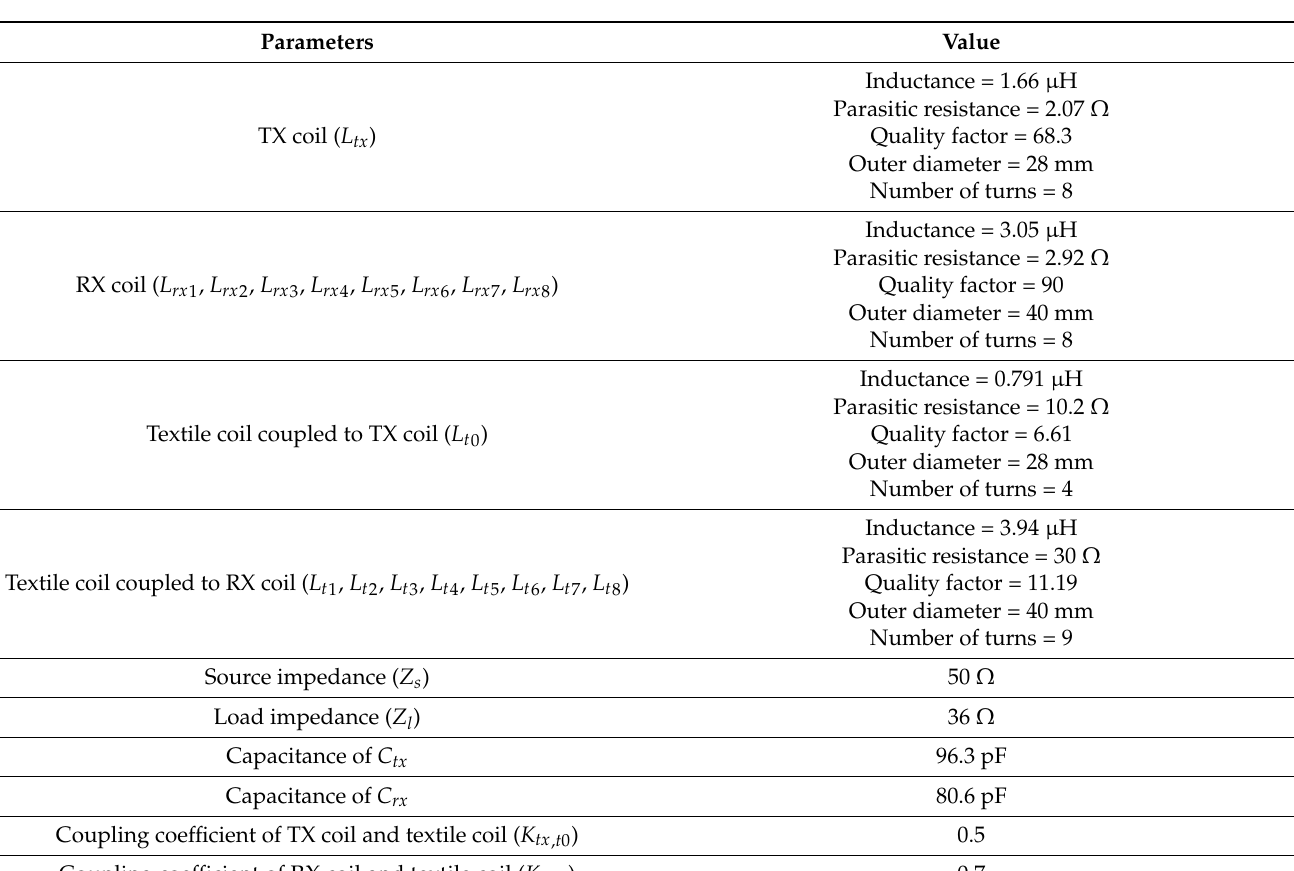
Figure 7. Design and experimental process. Table 1. Proposed system specifications.